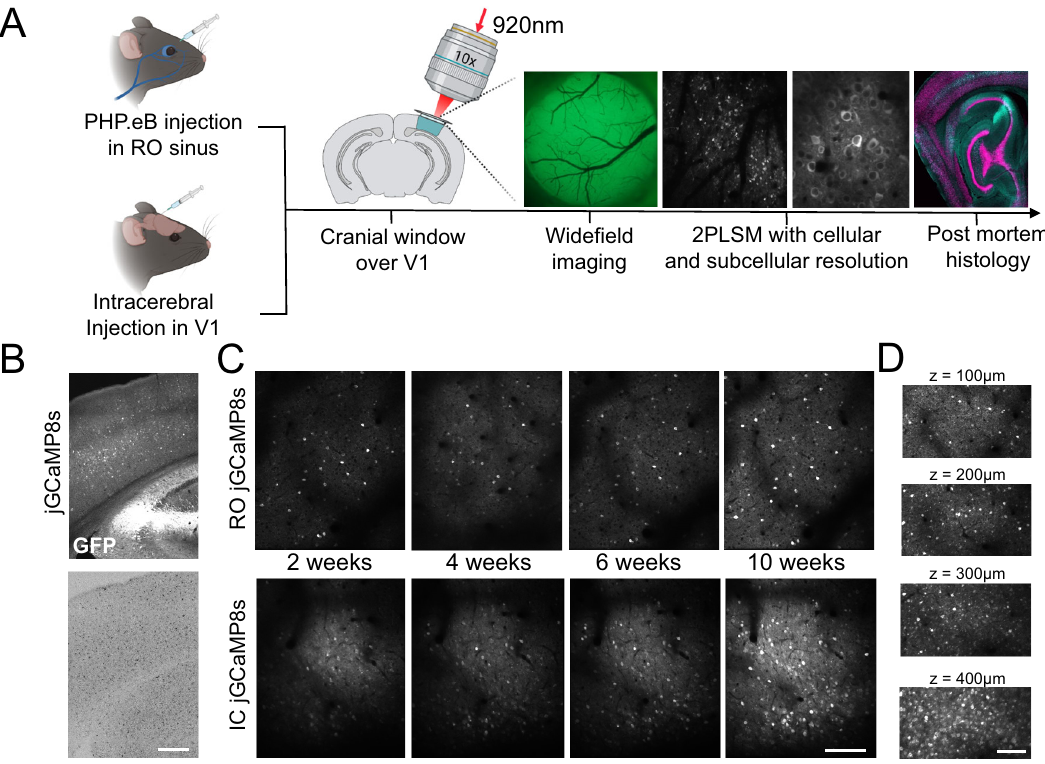
Fig. 1 | Systemic and local administration of GECIs using PHP.eB AAVs. A Experimentaloverviewindicatingthetwoinjectionmethods,andtheapproaches used to monitor the expression. Illustration created with Biorender.com. B Post- mortem histological veri fi cation of jGCaMP8s expression 10 weeks after RO injec- tion and microglia activation veri fi ed by Iba1-positive labeling. Scale bar indicates